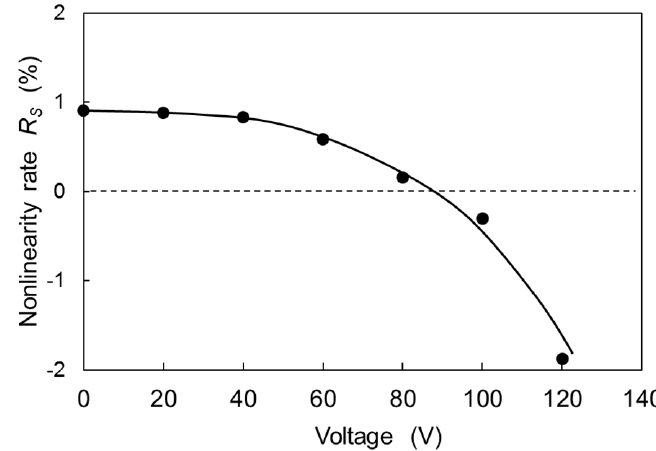
Figure 10. Mechanical scan angle measured as a function of the frequency with the voltage V applied to the compensation combs as a parameter.